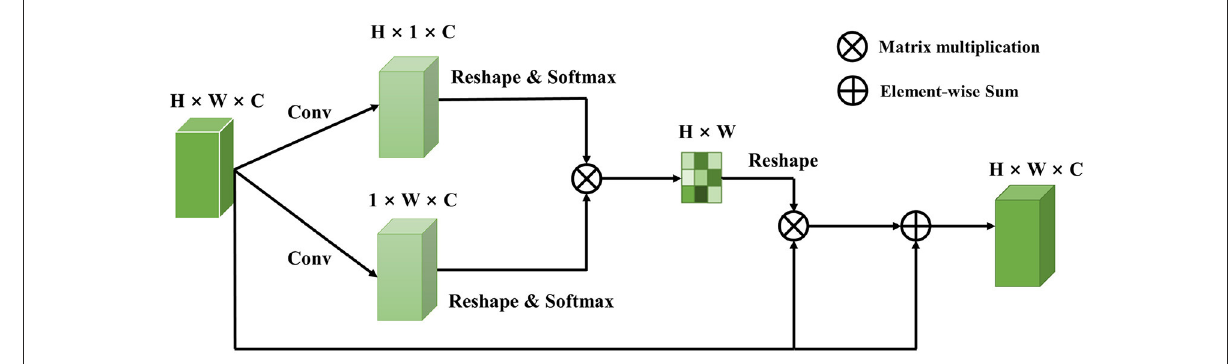
FIGURE2 The detail of Dual Attentive Fusion